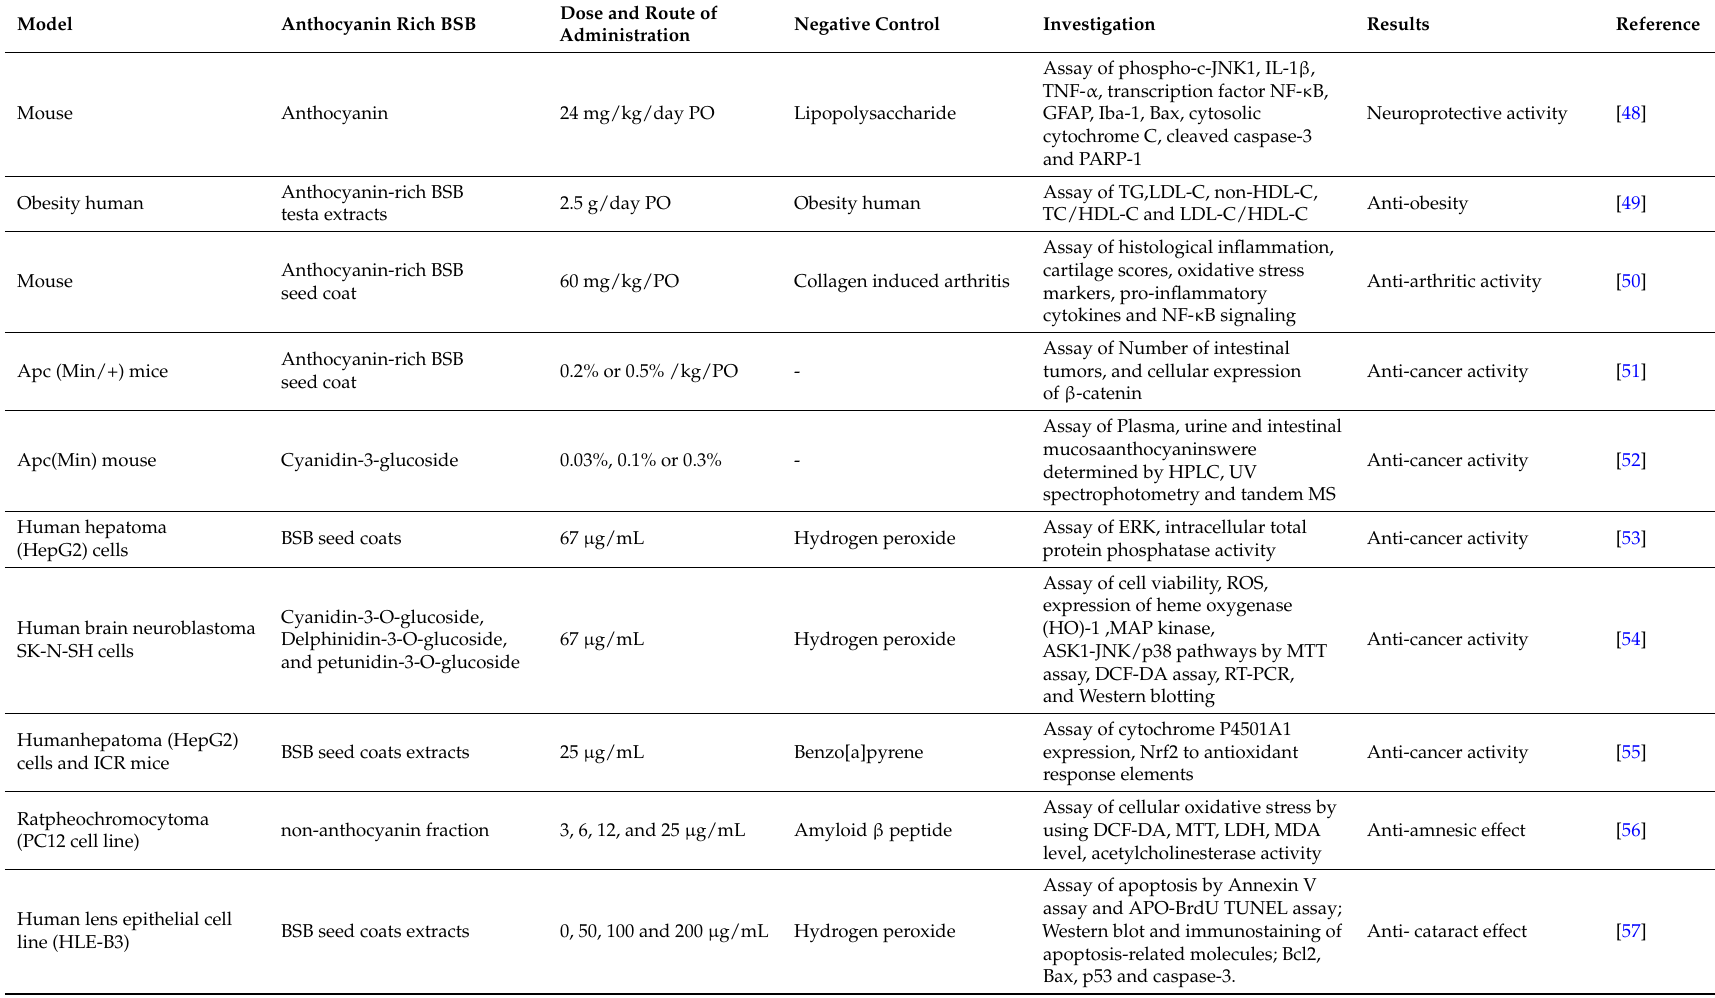
Table 1. Summary of in vivo and in vitro studies of health benefit potentials of Anthocyninsrich